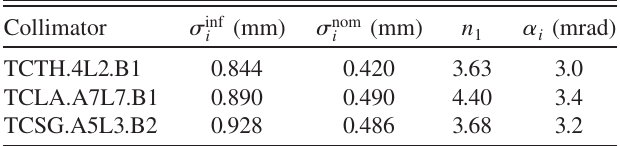
TABLE V. Predicted misalignment angles for the collimators with the highest beam size ratios. The difference between the nominal and the inferred beam sizes at these collimators, and hence the predicted misalignment angle, decreases after tunnel realignment.